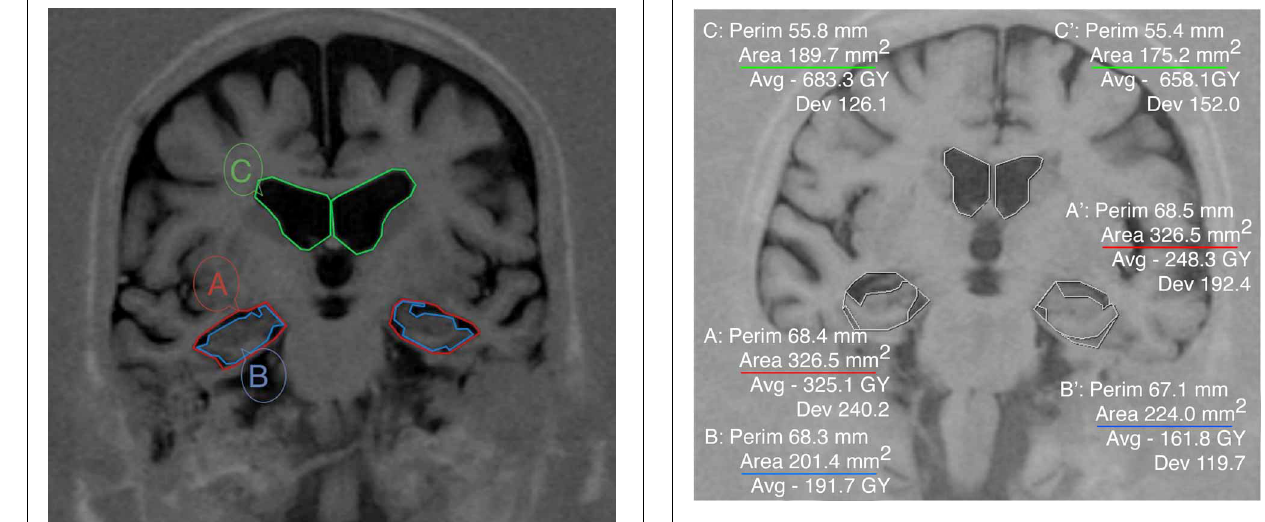
FIGURE 2 | Example of the Medial Temporal Atrophy index (MTAi) in a patient with mild AD. The three areas were traced manually on each hemisphere using the software for visualizing radiological images IMPAX. The data needed to compute the index are displayed automatically. We have underlined the different areas in colors as in Figure 1 . The MTAi in the right hemisphere is: rMTAi = (326.5 − 201.4) × 10 / 189 . 7 = 6 . 59. The MTAi in the left hemisphere is: lMTAi = (326.5 − 224.0) × 10 / 175 . 2 = 5 . 85. Note how in spite of the coincidence of this case with exactly the same medial temporal region (A and A’) in both hemispheres, the right MTAi is clearly higher than the left MTAi. Indeed when we calculate the Index of Asymmetry (IA), it is higher than 3: IA = (5, 85 − 6.59)/(5, 85 + 6.59) × 100 = − 5 , 15%. Table 1 | Mean of the mean Medial Temporal Atrophy index (mMTAi) and Index of Asymmetry (IA) values in short series of patients with MCI (3), mild AD (3), moderate AD (3), severe AD (3), FTLD -not staged- (3), LBD -not staged- (3) and 5 healthy controls. Values are merely illustrative -not